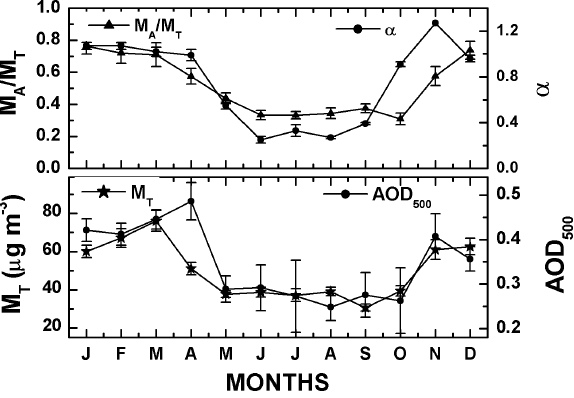
Fig. 9. The monthly mean values of total mass concentration of composite aerosols and columnar AOD at 500nm (the bottom panel) and ratio of accumulation mode mass concentrations to total (M A /M T ) and the Ångström wavelength exponent ( α ) (top panel). The vertical line through the point represents the standard deviation of the mean.